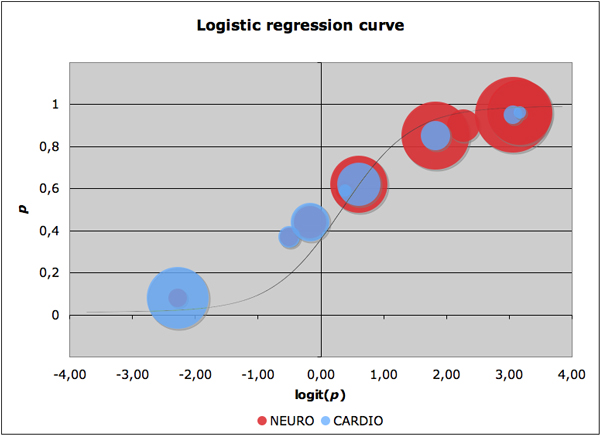
Calculated logistic regression curve for the considered neurobiology (NEURO) or cardiovascular system (CARDIO) related genes. Each point area indicates the number of considered genes with a calculated regression value (logit(p)) and estimated probability (p), of belonging to the NEURO class, corresponding to the point center.